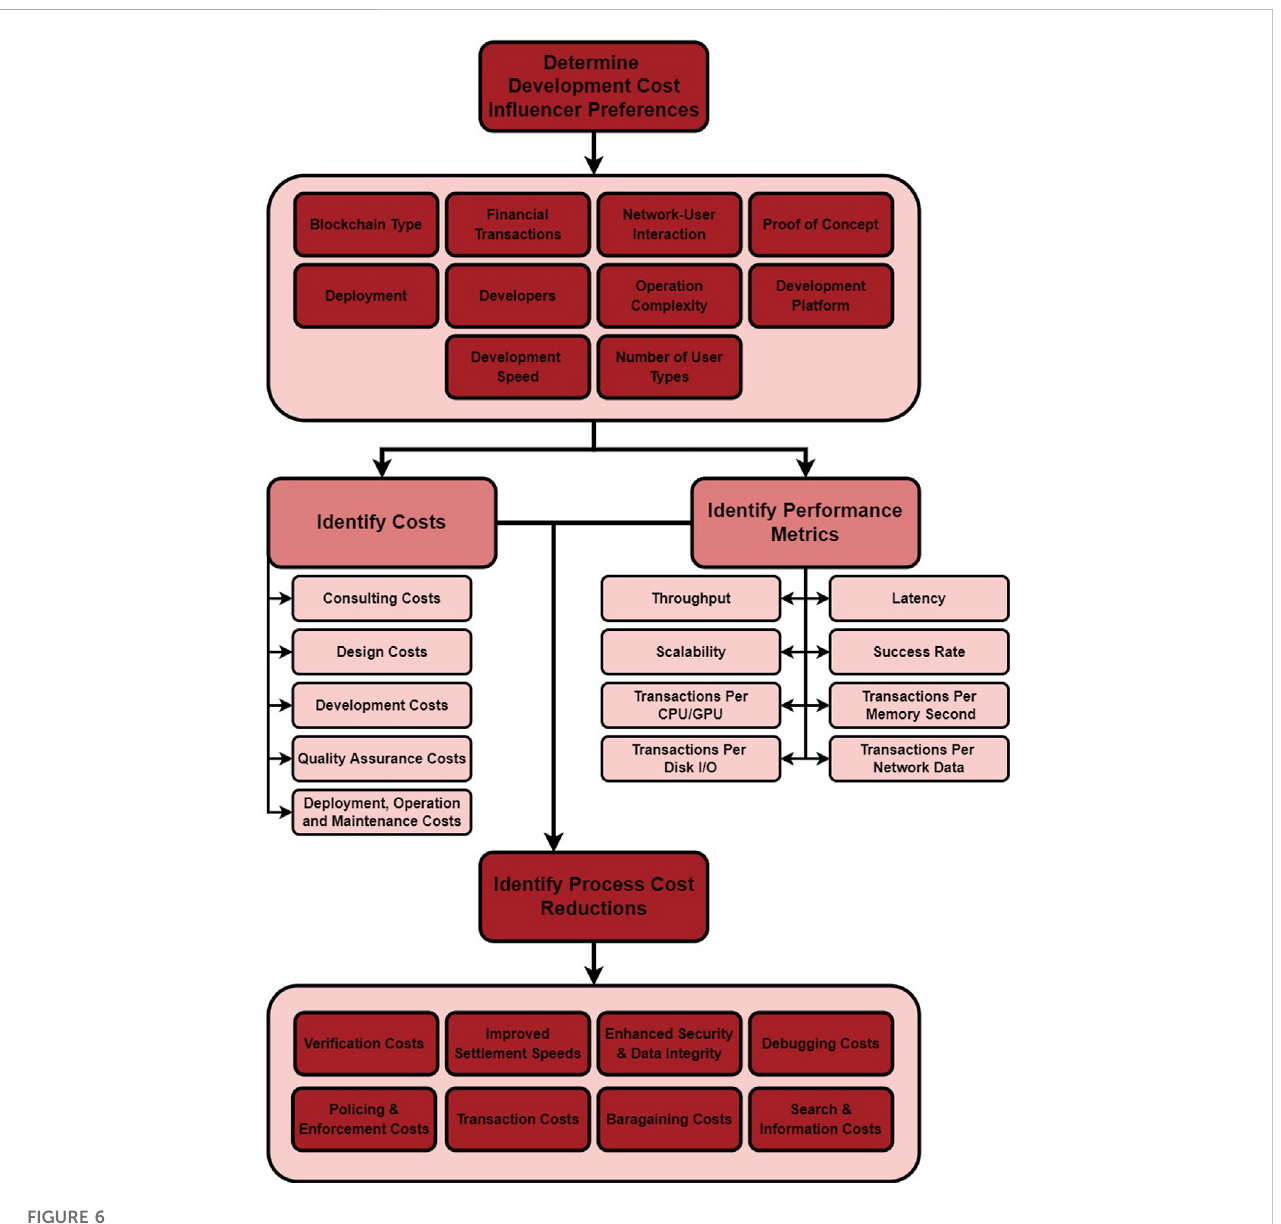
FIGURE 6 Value Analysis